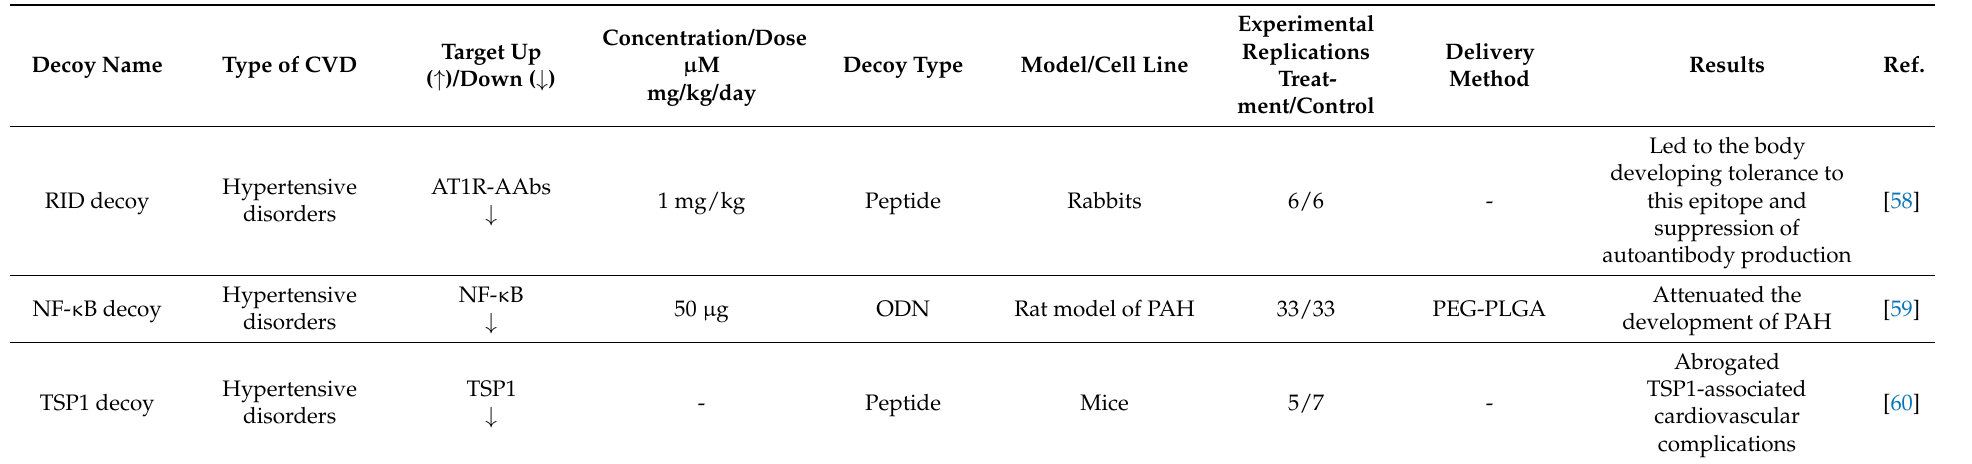
Abbreviations used in this table: AAA: abdominal aortic aneurysm; AP-1: activator protein-1; DC: dendritic cells; HVJ liposomes: hemagglutinating virus of Japan liposomes; IL: interleukin; MCP-1: monocyte chemoattractant protein-1; MMP: matrix metalloproteinases; NF- κ B: nuclear factor-kappa B; ODN: oligodeoxynucleotides; PLB: phospholamban; VSMCs: vascular smooth muscle cells; SD: Sprague–Dawley; SMCs: smooth muscle